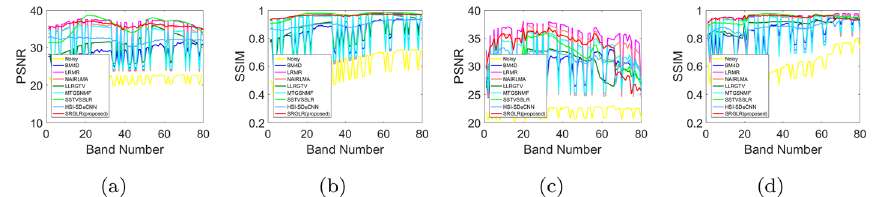
Fig. 5 PSNR value and SSIM values of each band in the Pavia City Center image a , b and the Washington DC Mall image c , d with Case 1.3 and Case